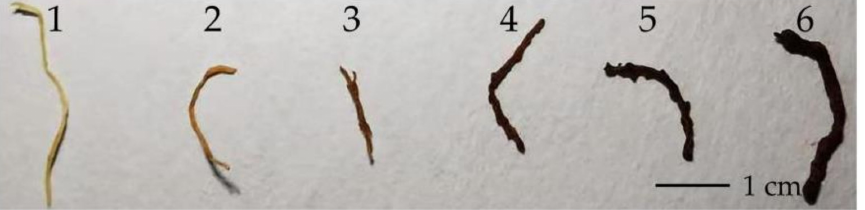
Figure 1. Morphology of puffed CRMG: ( 1 ) Control; ( 2 ) 196.1 kPa; ( 3 ) 294.2 kPa; ( 4 )392.3 kPa; ( 5 ) 490.3 kPa; ( 6 ) 588.4 kPa.